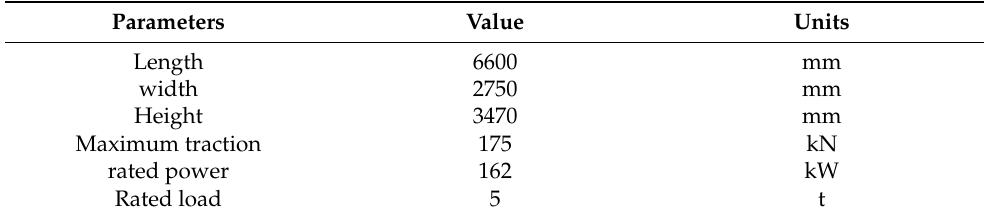
Table 1. Basic parameters of the experimental wheel